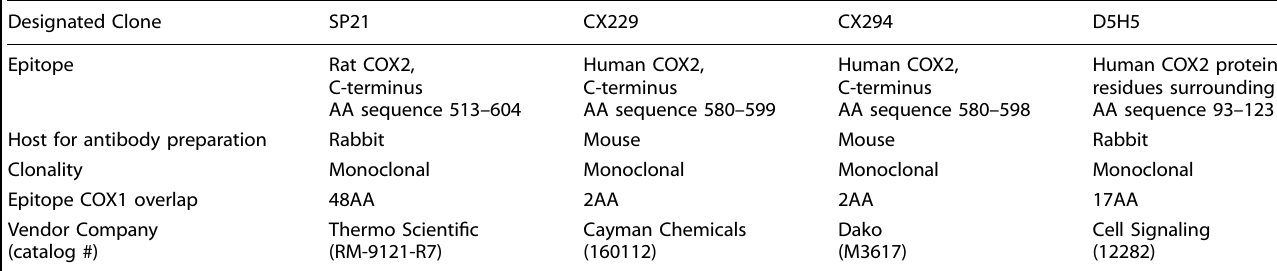
Table 1. Comparison of structural properties of two COX2